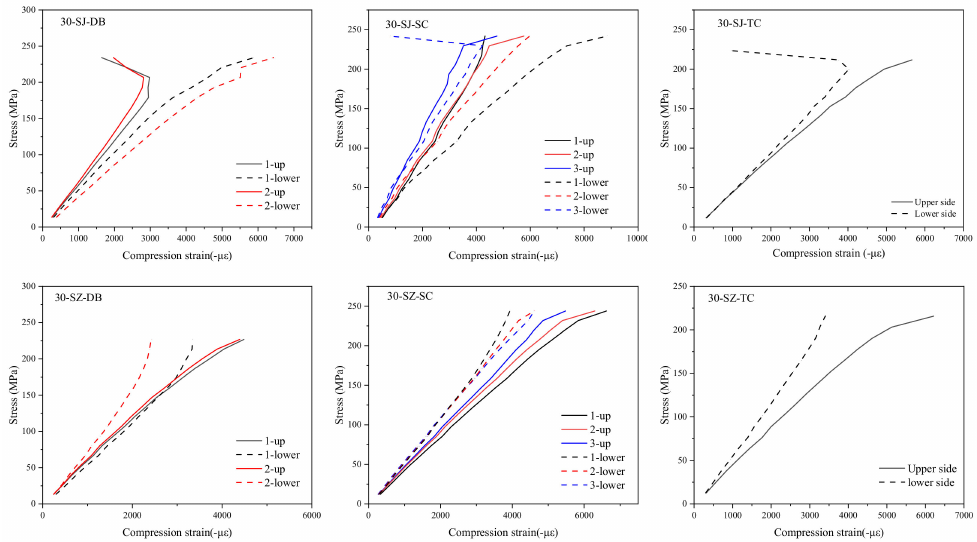
Figure 7. Stress–strain curves of specimens with particle density of 30 g/m 2